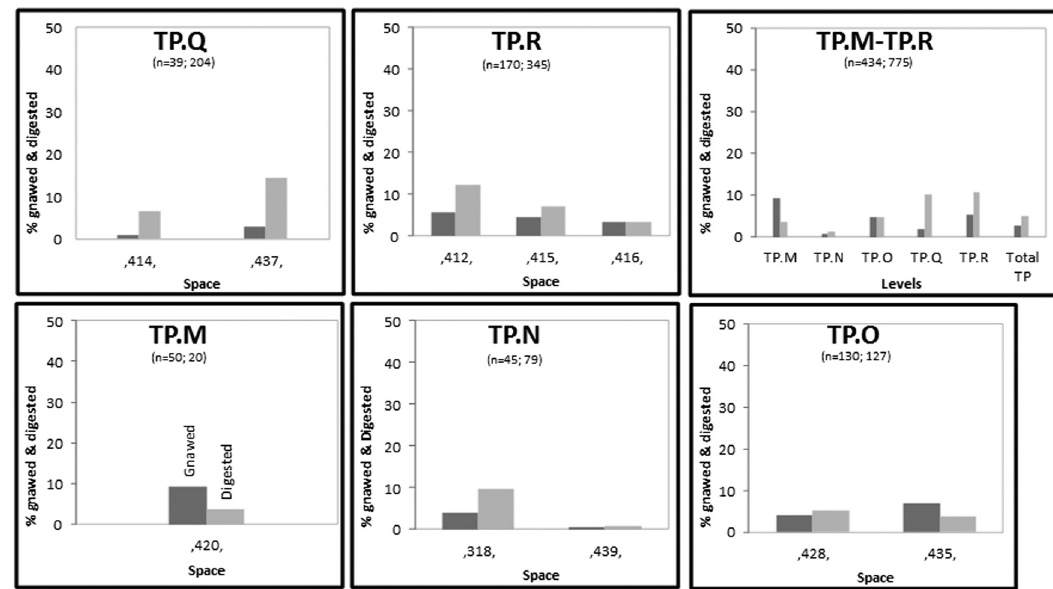
Figure 6: Çatalhöyük East, TP middens. Frequencies of the gnawed and digested bones within the spaces in each level in the TP sequence.